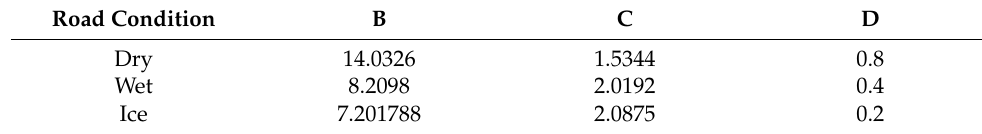
Table 2. The parameters of the three most commonly used runway